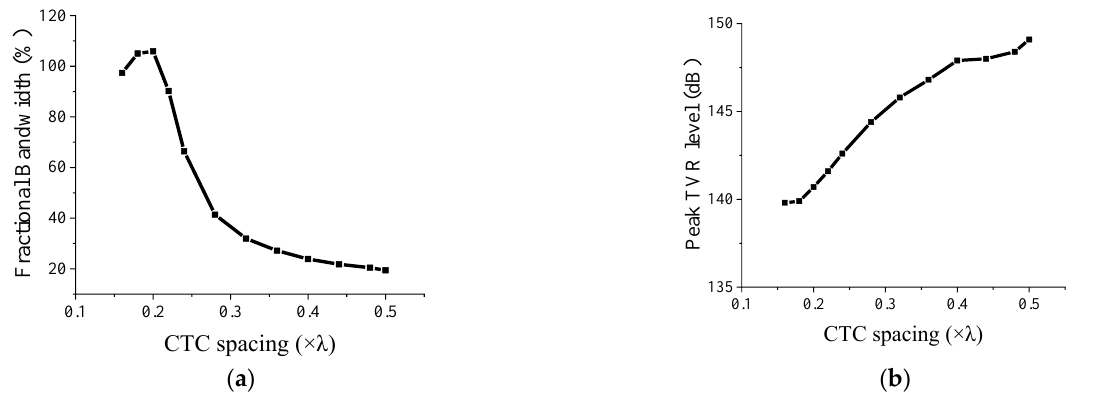
Figure 13. Acoustic characteristics of the 3 × 3 two-layered cymbal array vs. CTC spacing: ( a ) FB; ( b ) peak TVR level.